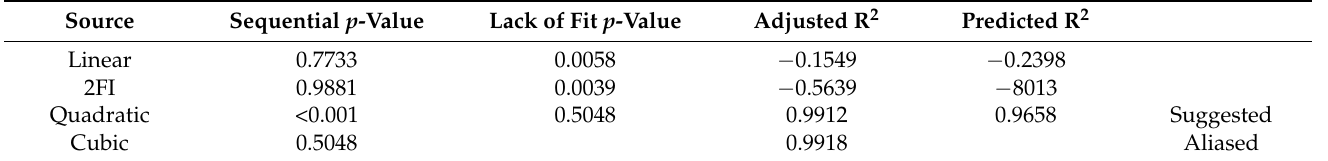
Table 4. Fit summary for current